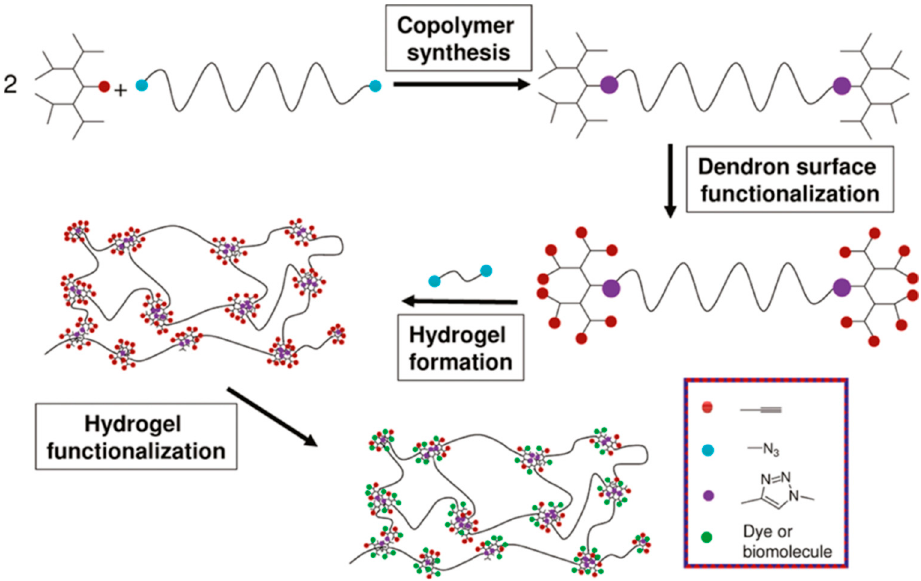
Figure 16. Schematic illustration of dendron polymer conjugate synthesis and hydrogel formation. Reprinted with permission from [42], Copyright © 2010 American Chemical Society.